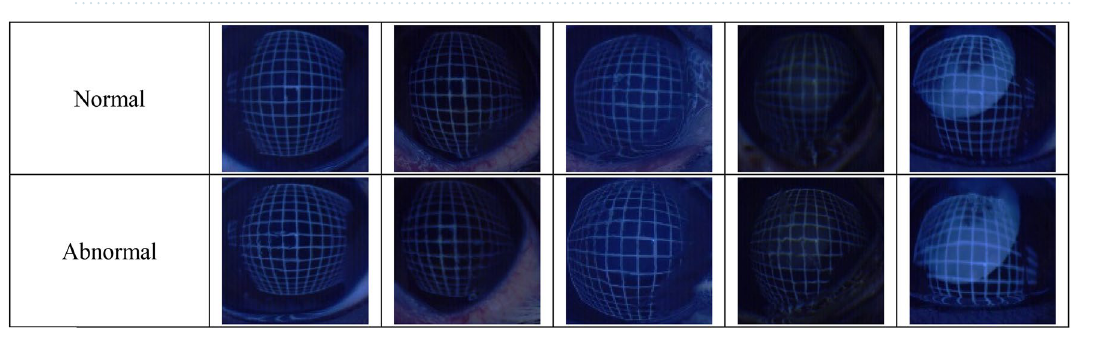
Figure 4. Examples of normal and abnormal